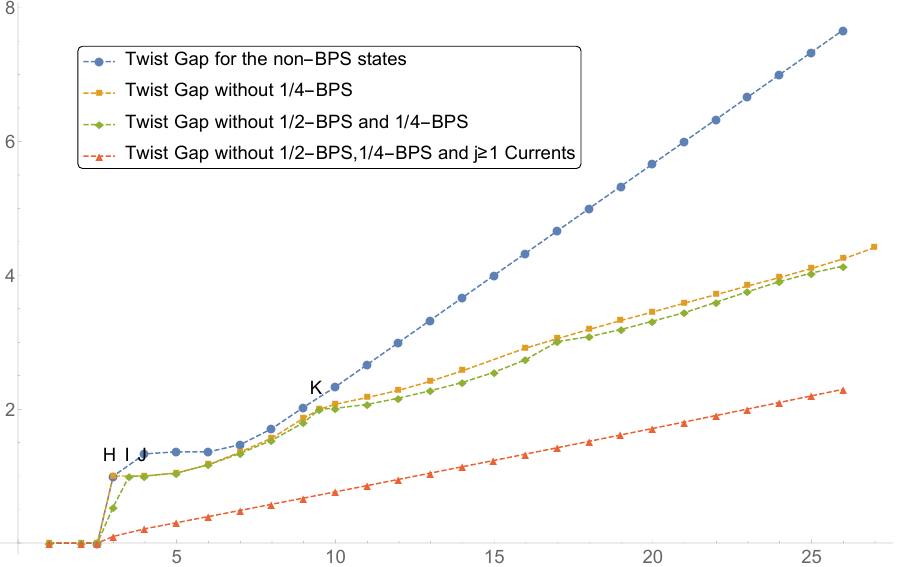
Figure 2 . Numerical upper bounds on the twist gap for the N = 2 SCFTs under various assump- tions. The blue line represents the most generic bounds for the N = (2 ; 2) SCFT. for c & 6. There is a kink (H) at c = 3, (cid:1) = 1, at which we observe the t